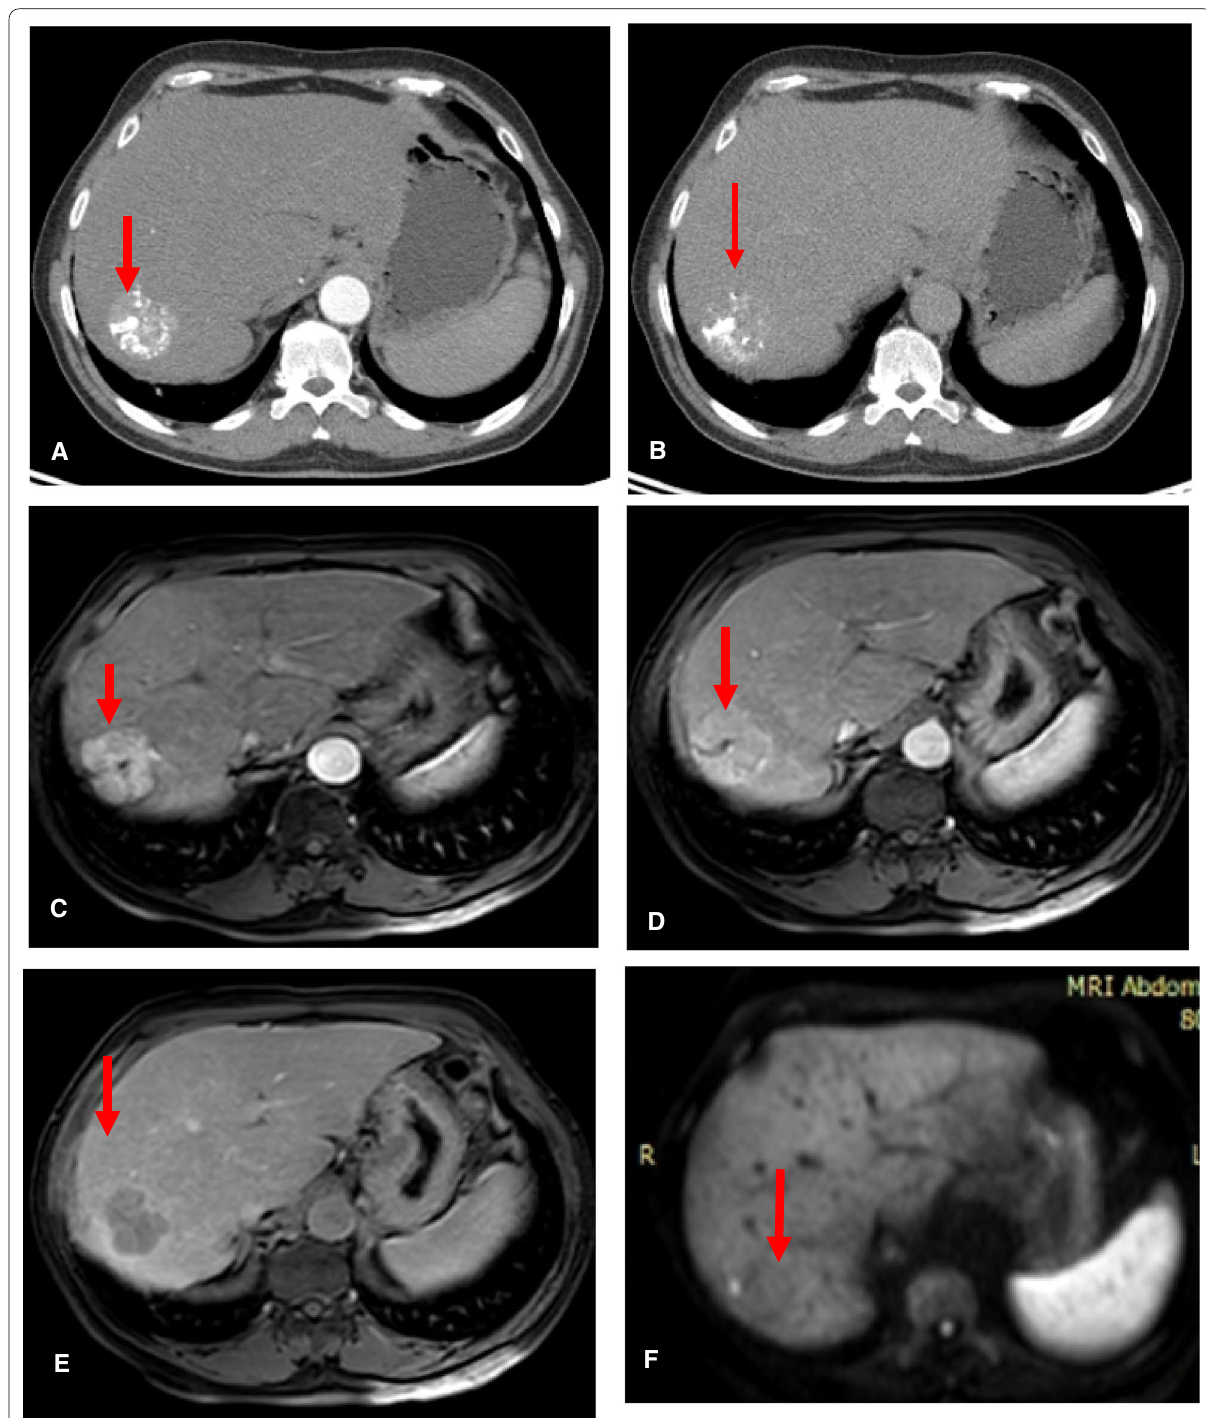
Fig. 1 63 years old male patient underwent TACE. PET/CT uptake with diffusion restriction in TR‑LR viable lesion. A , B Axial arterial phase ( A ) and venous phase ( B ) CT images showing embolized lesion with heterogeneous lipiodol concentration, APHE and washout (red arrow). C – E Axial arterial ( C ), venous ( D ) and delayed ( E ) dynamic contrast MRI images also showing APHE, delayed washout and delayed capsular enhancement (TR‑LR viable). F – H DWI ( F ) and ADC map ( G , H ), the lesion is iso‑intense in the DWI with low ADC value compared to the adjacent liver, the mean ADC of the lesion is 1.12 10 − 3 mm 2 /s. I – K Axial PET/CT fused images showing increased FDG uptake in the residual lesion achieving SUV max of × 2.59 while the mean SUV of the liver was 1.66 (SUV ratio is